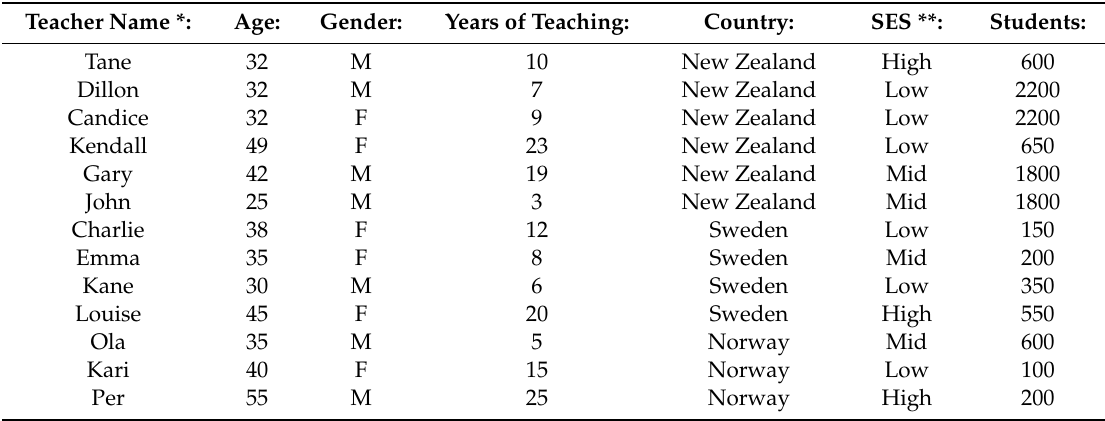
Table 1. Research participants and school